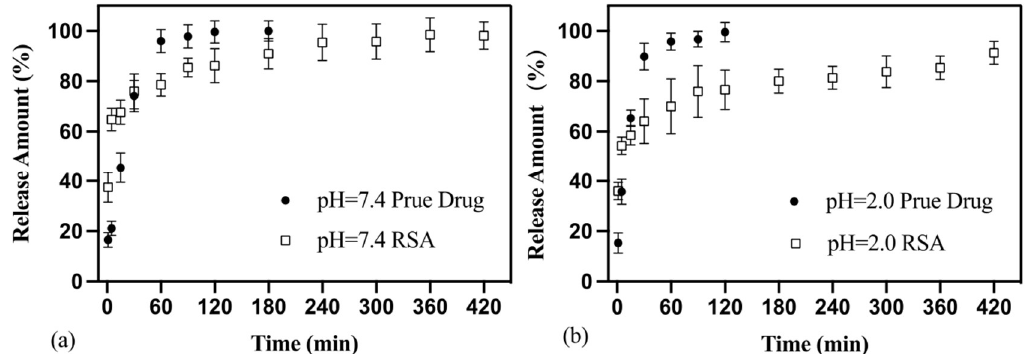
Figure 6. Release data of RSA and pure drug in phosphate-buffered solution (pH = 7.4) ( a ) and simulated gastric fluid (pH = 2.0) ( b ) at 37 °C.